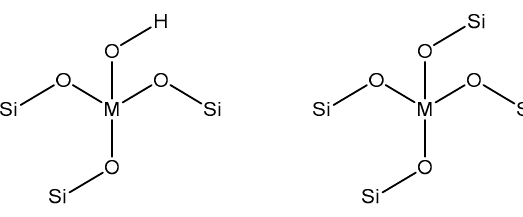
Figure 9. Distinct open ( left ) and closed ( right ) metal ion sites in M/BEA (M = Zr, Sn, Ti) [49,70–75].